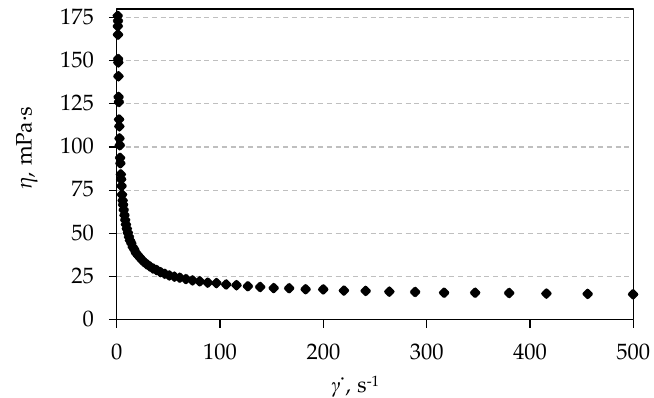
Figure 4. Plot of apparent viscosity ( η ) versus increasing shearing rate ( γ ̇ ) for 70 wt.% Al 2 O 3 water based suspension which contains 20 dwb.% of waste Al 2 O 3 powder, with optimal amounts of additives.